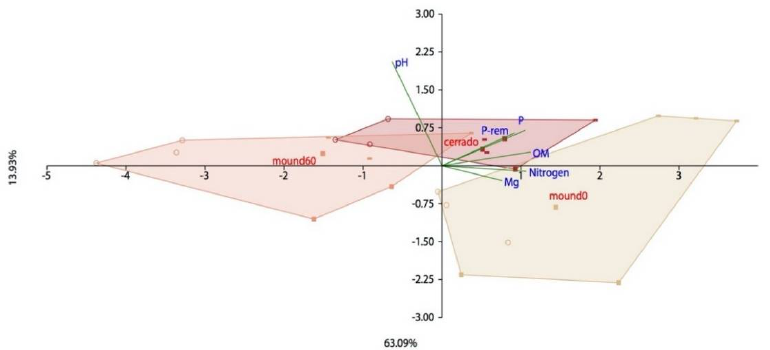
6 of 15 Figure 4. Non-metric dimensional scale analysis from the Cerrado soil samples (50–60 cm), mound surface (0–10 cm), and mound soil (50–60 cm) at the dry, transition, and rainy seasons. ( A ) Non-Metric